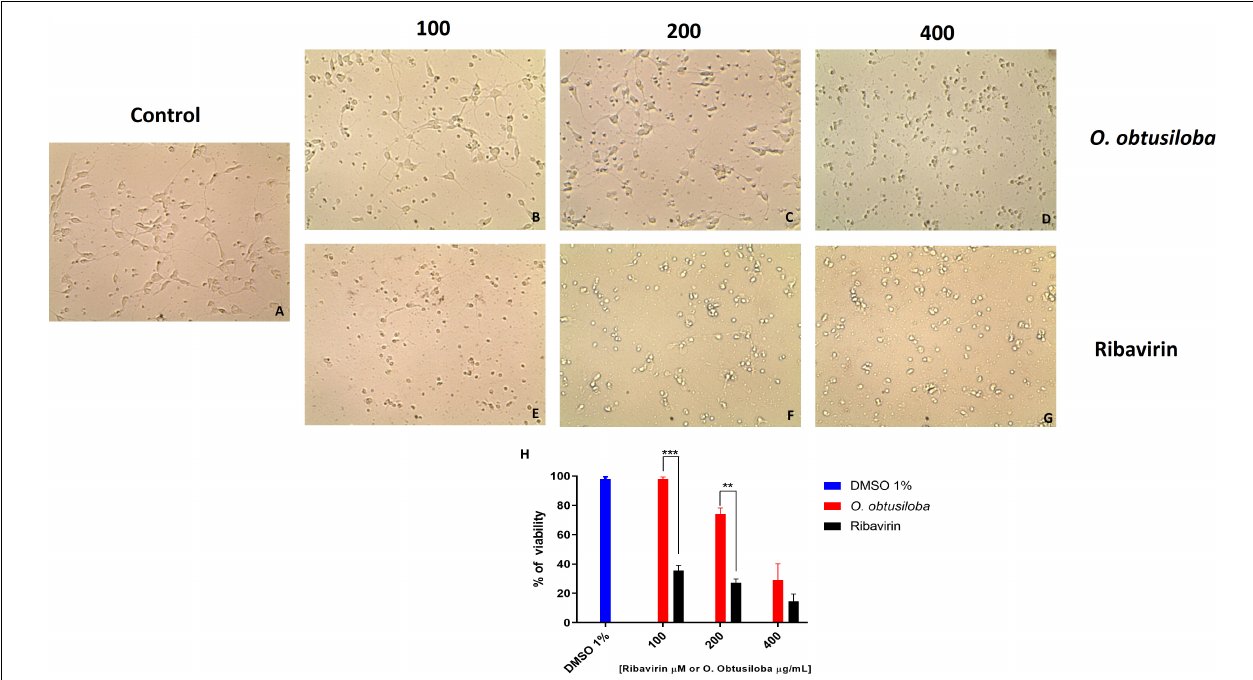
FIGURE 2 | Cytotoxicity of O. obtusiloba extract and ribavirin in chick retina neurons in 4-day-old purified cultures. (A) Control culture. (B,C,D) Cultures incubated with O. obtusiloba at concentrations of (B) 100 µ g/mL, (C) 200 µ g/mL and (D) 400 µ g/mL. (E,F,G) Cultures incubated with ribavirin at concentrations of (E) 100 µ M, (F) 200 µ M and (G) 400 µ M. (H) Graphical representation showing the percentage of viability of treated cells with O. obtusiloba (blue bar) and percentage of viability of treated cells with ribavirin (dark bar). The results were evaluated by MTT assay and showed that the exposure to the O. obtusiloba extract presented low cytotoxicity maintaining high viability in concentrations up to 200 µ g/mL. Error bars indicate the standard deviation and experiments were performed in triplicate. ∗∗ p < 0.01; ∗∗∗ p < 0.001 in Tukey test.